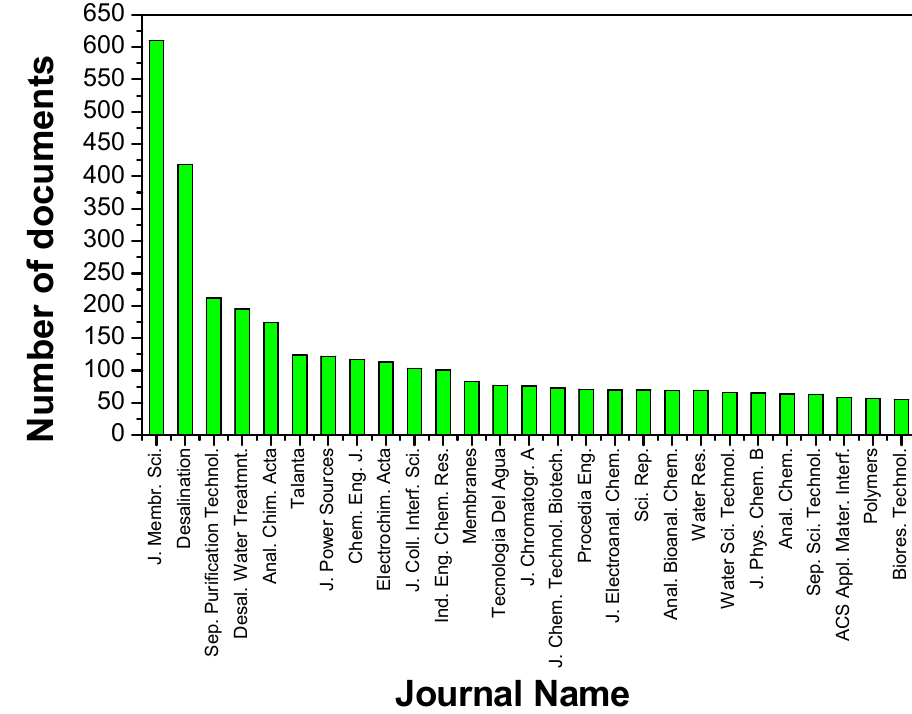
Figure 3. Spanish ‐ based publications by the most productive early journals from 1960. (Source: Scopus, Keyword “Membrane” and Affiliation “Spain”).